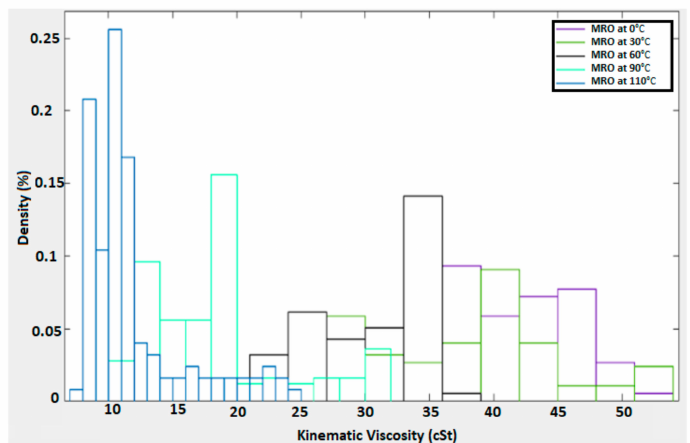
Figure 13. Distribution of kinematic viscosity of MRO as % density